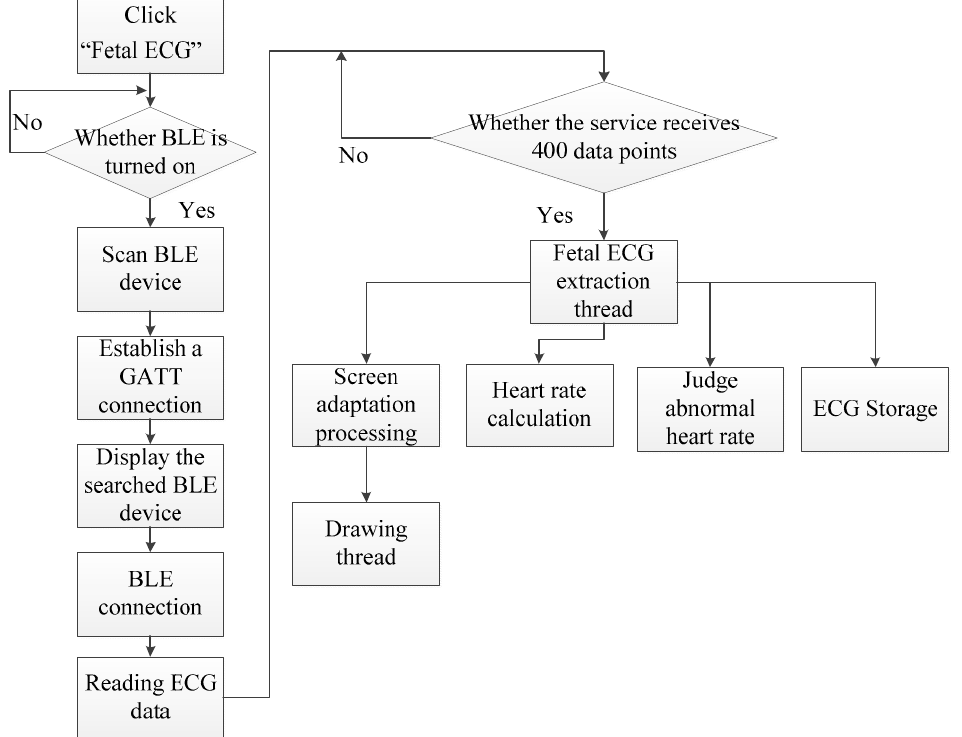
Figure 6. Flow chart of the Android app software.